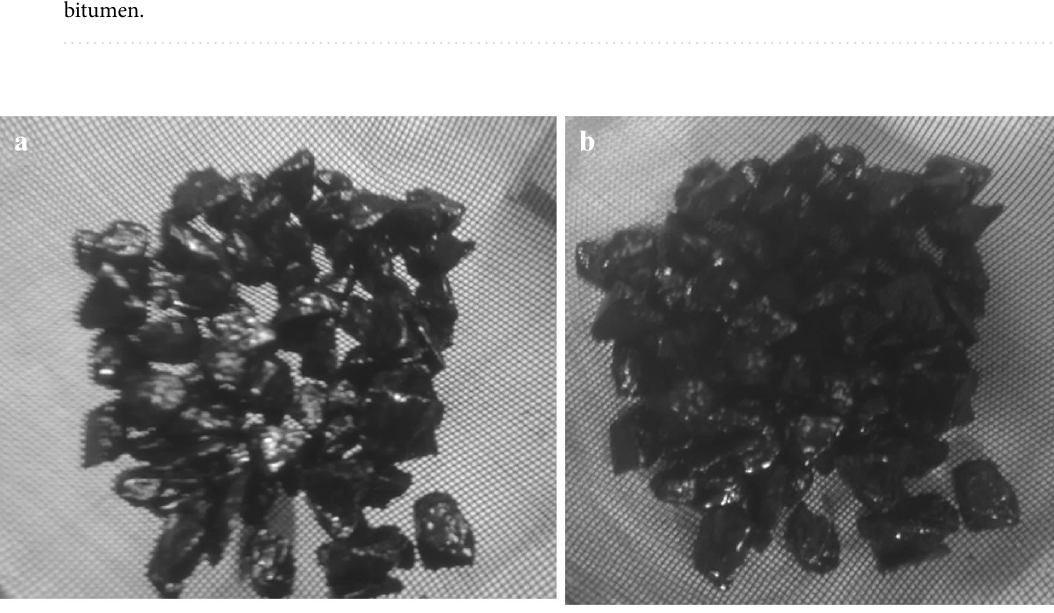
Figure 3. Adhesion of oxidized ( a ) and non-oxidized ( b ) bitumen to acidic